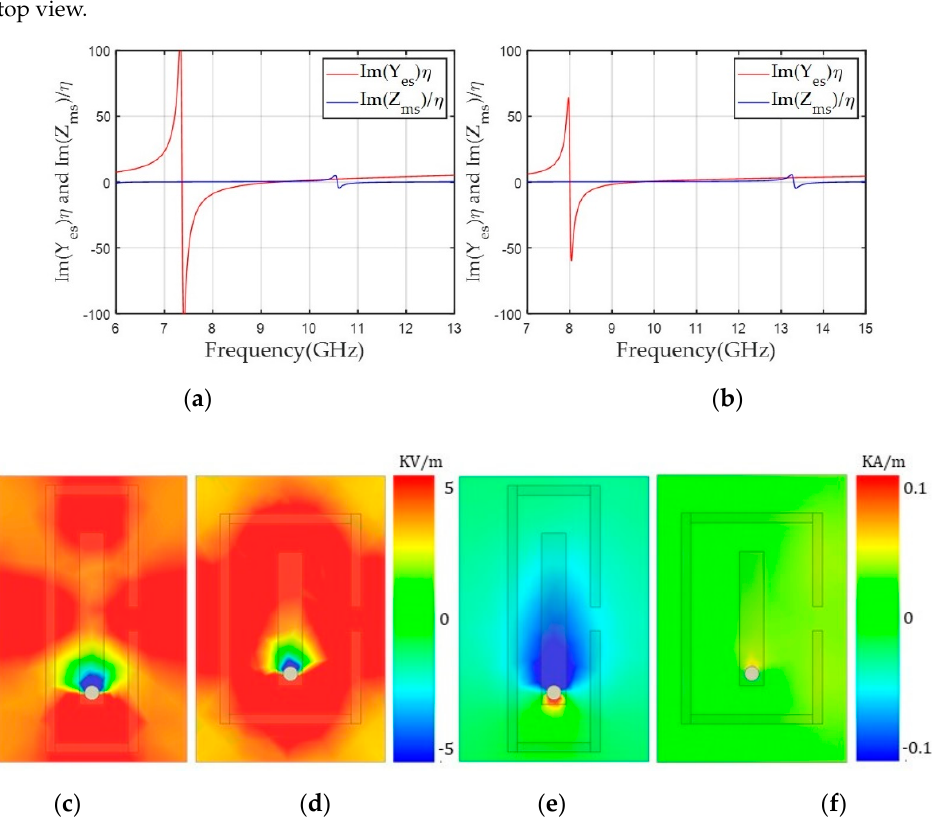
Figure 9. Y es and Z ms values of the unit cell according to frequency for transmission phases of ( a ) − 60 ◦ and ( b ) − 30 ◦ . The y component of the electric field (E y ) for transmission phases of ( c ) − 60 ◦ and ( d ) − 30 ◦ . The x component of the magnetic field (H x ) for transmission phases of ( e ) − 60 ◦ and ( f ) − 30 ◦ along the x-y plane in the middle of the unit cell at 10 GHz.